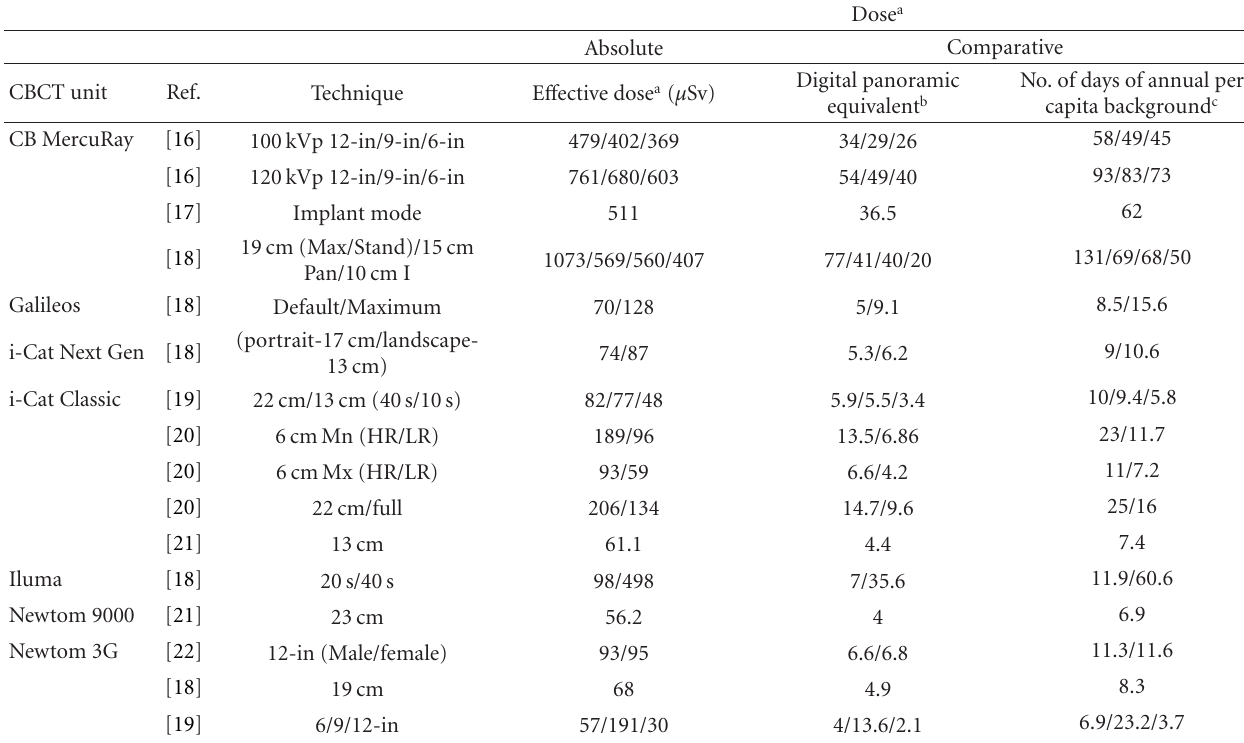
Dose a Absolute Comparative